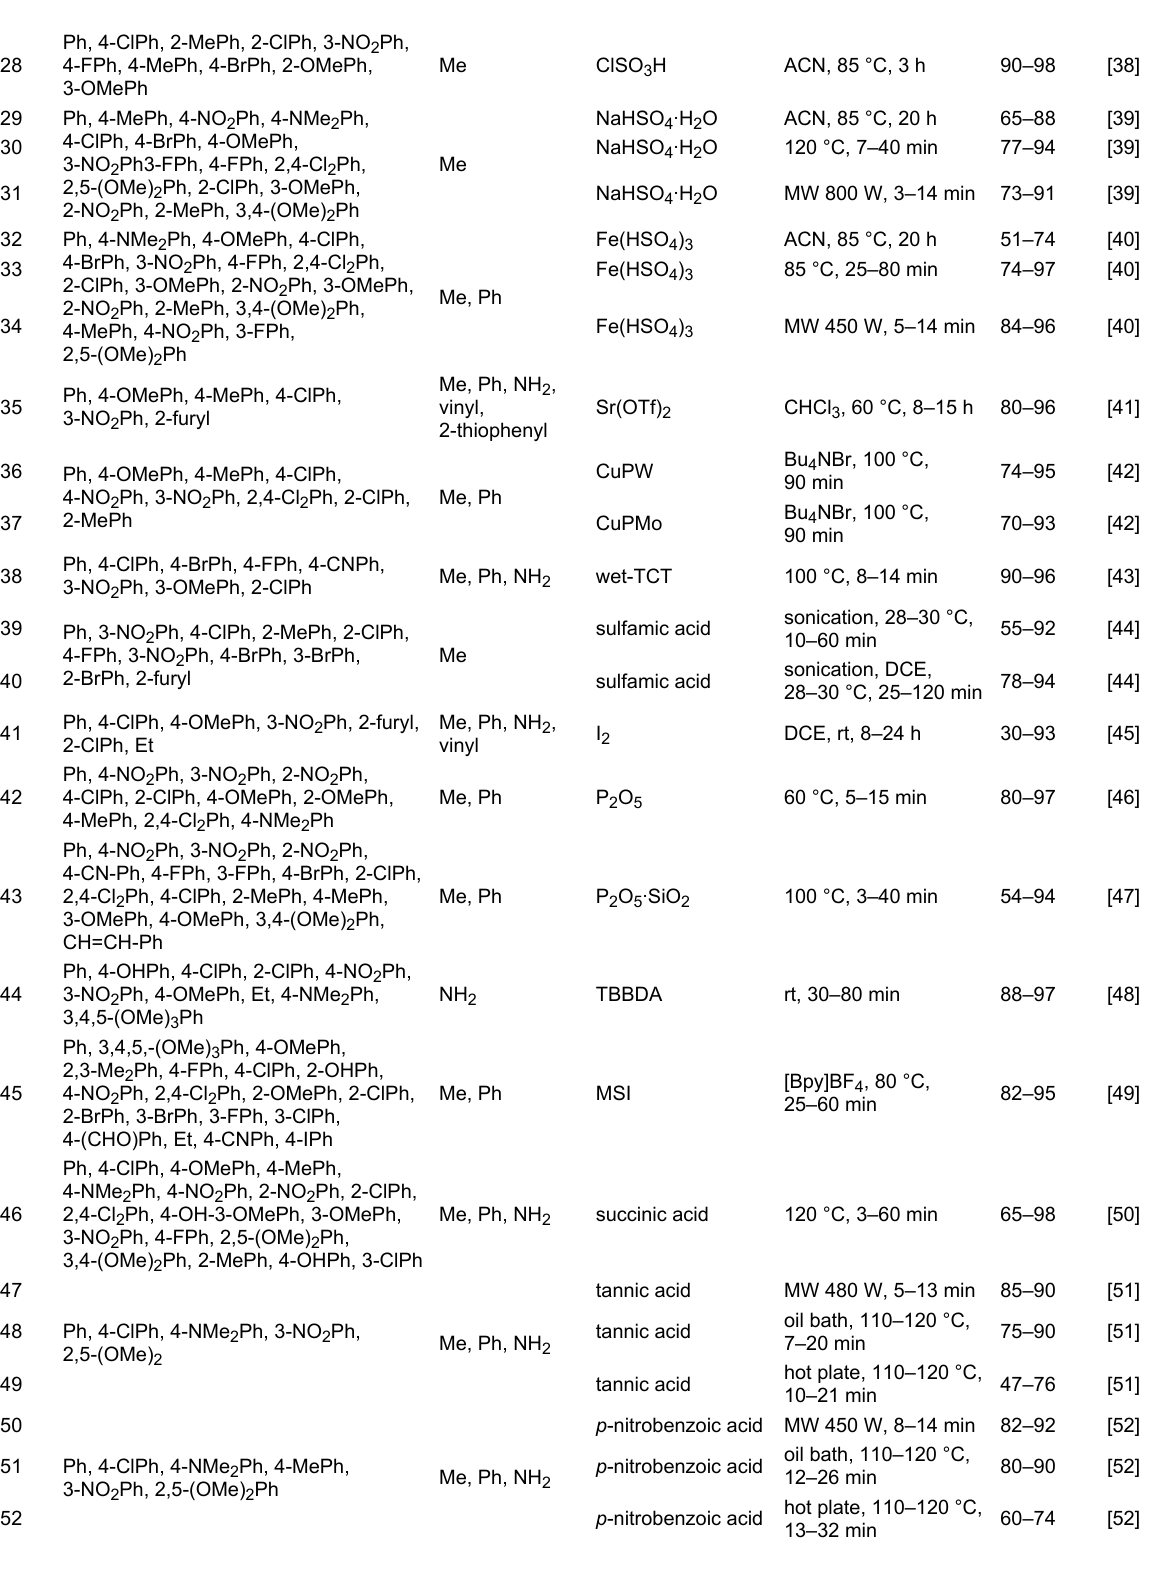
Table 1: Comparison of various conditions applied in the synthesis of amidoalkylnaphthols 4 . (continued)